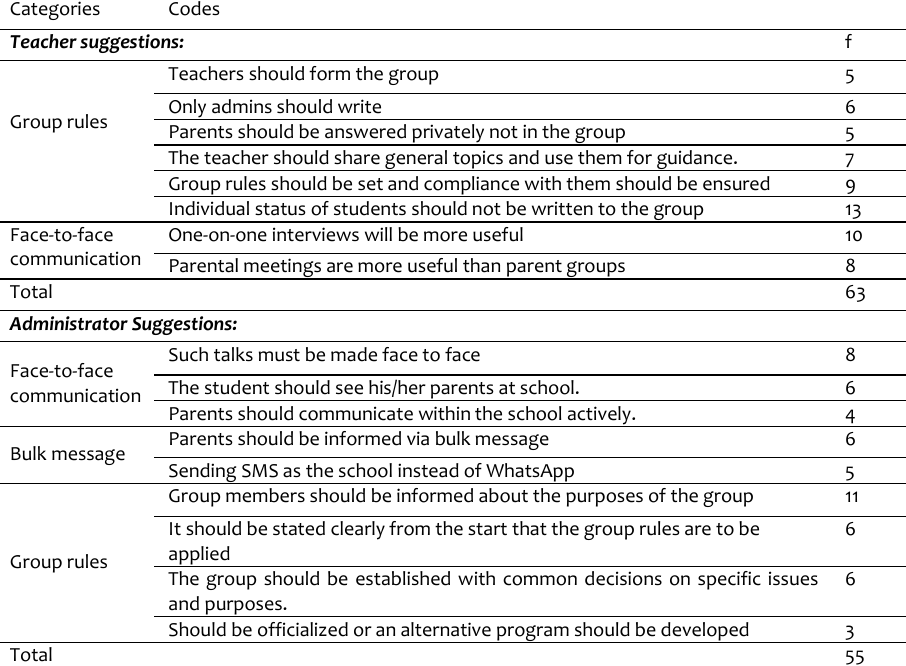
Table 3: Teachers' and administrators' suggestions on teacher-parent Whatsapp